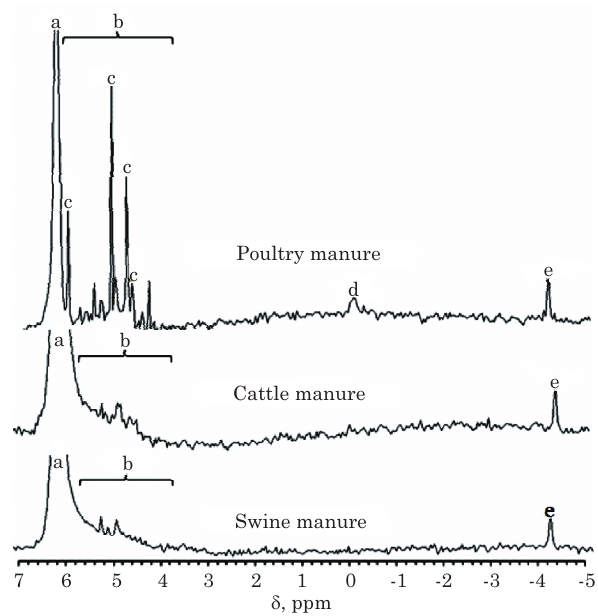
Figure 2. Solution 31 P nuclear magnetic resonance spectra of poultry, cattle, and swine manure. The letters indicate the P form as follow: a = orthophosphate, b = monoester phosphates, c = Myo -inositol hexakisphosphate (phytate), d = diester phosphate (DNA), and e =